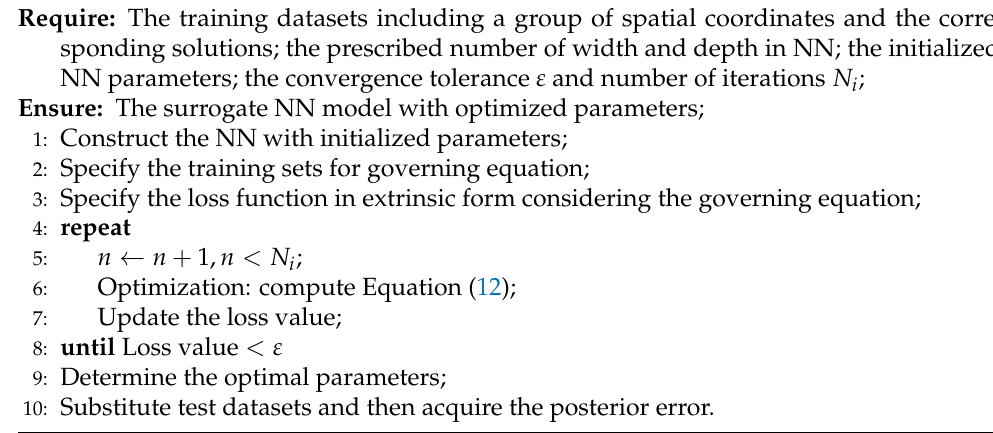
Algorithm 1 The extrinsic approach based on